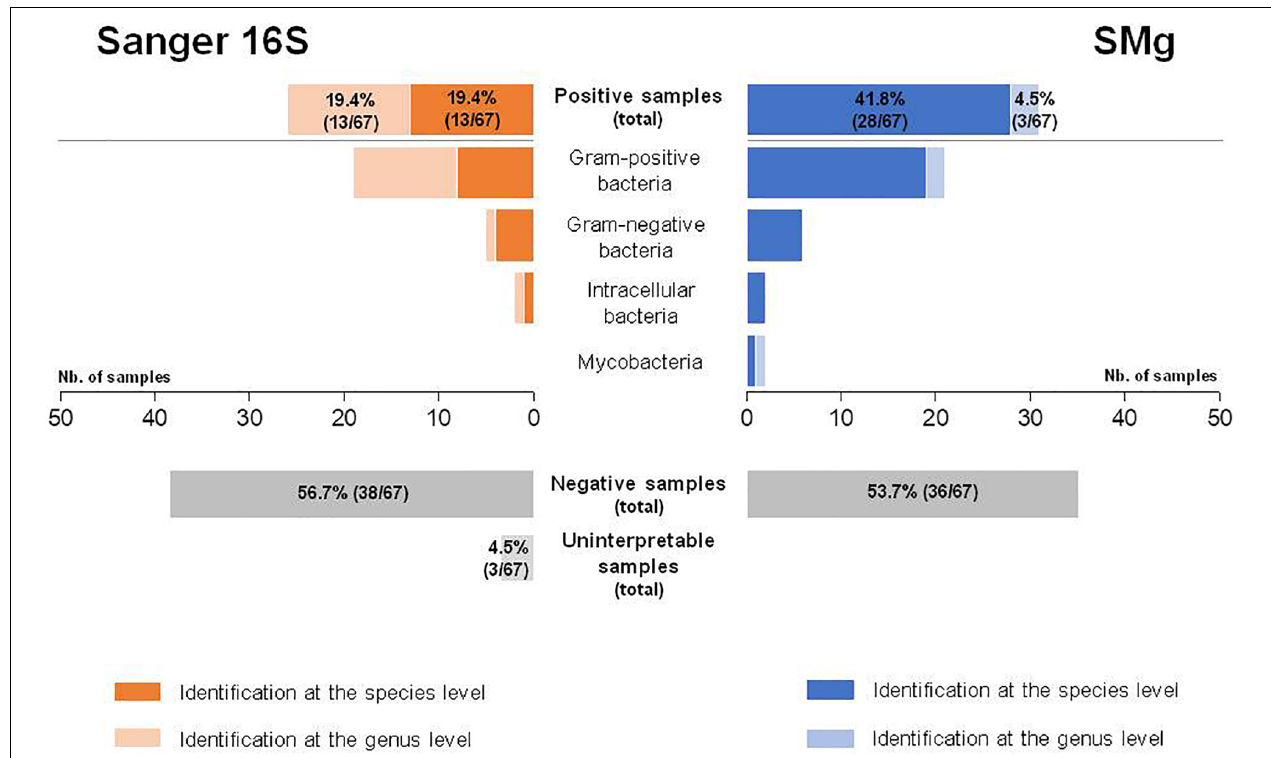
FIGURE 2 | Comparison of Sanger sequencing of the 16S rRNA gene (Sanger 16S) and shotgun metagenomics (SMg) for their ability to identify bacteria at the genus and species levels.